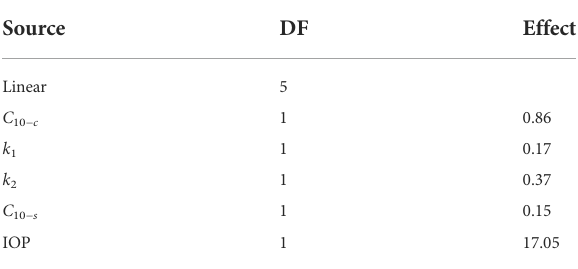
FIGURE 7 Evolution of normal stresses and strains at two locations (anterior and posterior) during the air puff. At the beginning of the air-puff both points are at a tension state due to the IOP. Then, duringtheair-puff,theanteriorsurfaceworksincompression (blue)andtheposteriorintension(red)withthecontributionofthe collagen fi bres.